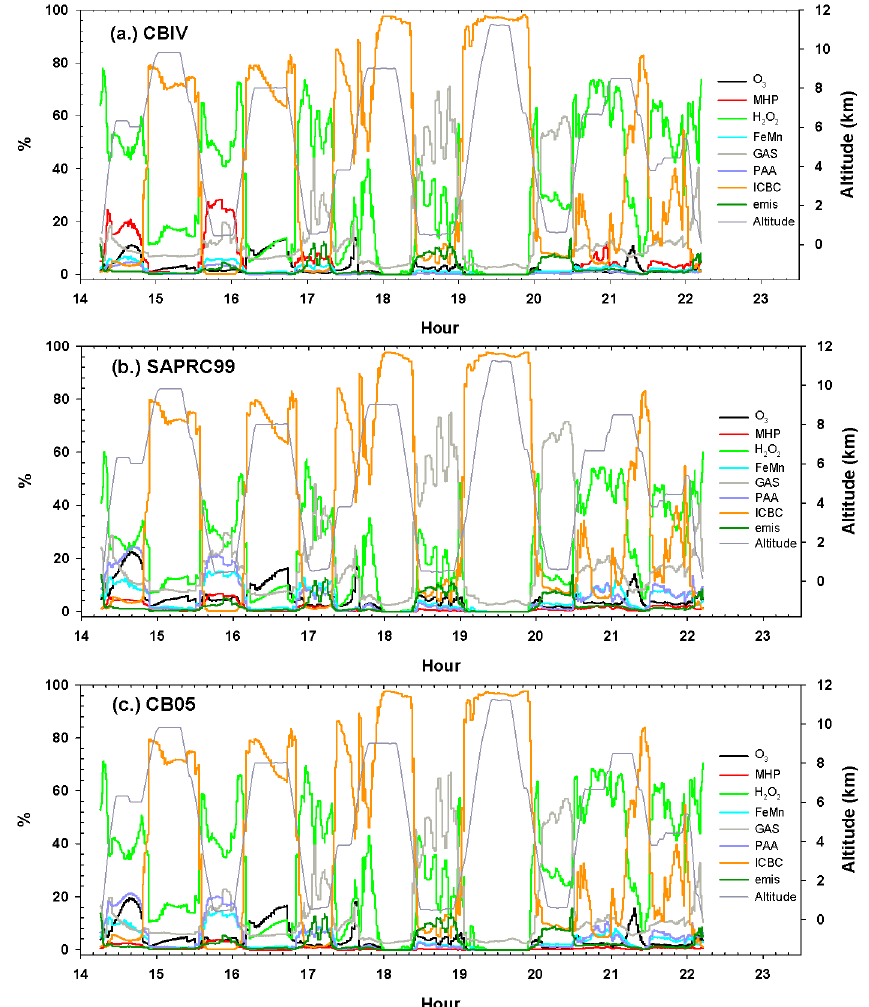
Fig. 3. Percent contribution of sulfate formation pathways to total sulfate for (a) CBIV, (b) SAPRC99, and (c) CB05 along the path of the